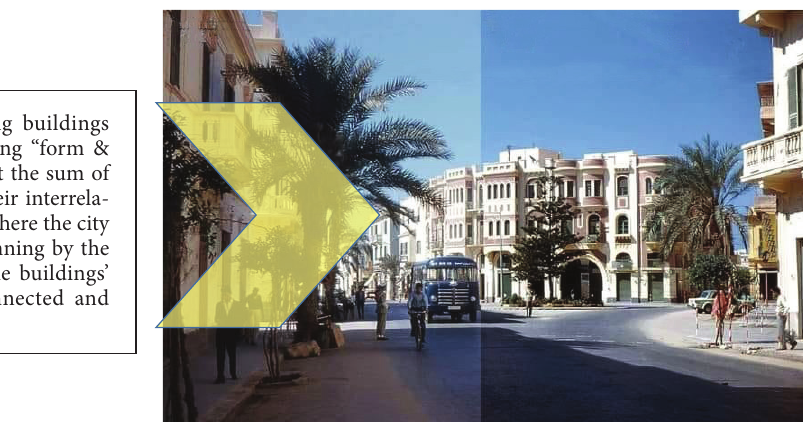
Figure 8. Attracting continuity of urban image through “Tree Square”